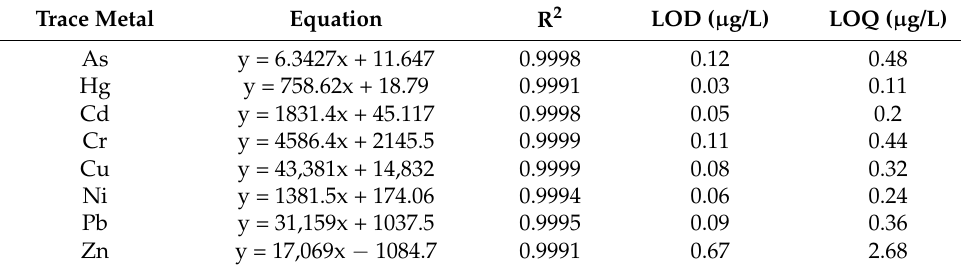
Table A4. Results of the linear relationship between the trace metals